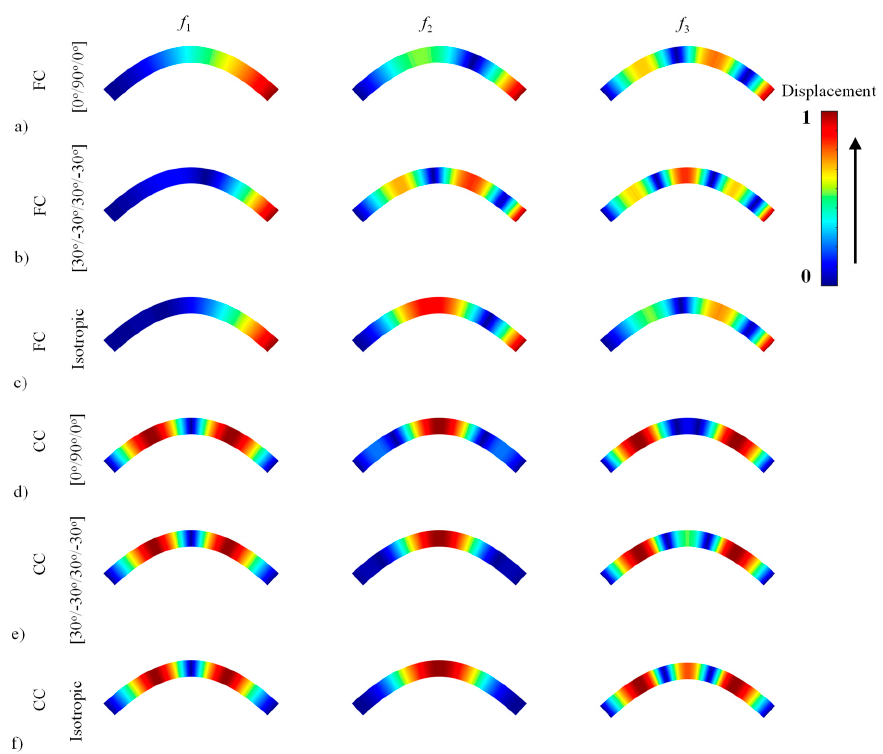
Figure A2. Several mode shapes for a paraboloidal composite laminated beam and a paraboloidal isotropic beam. Materials 2020 , 13 , x FOR PEER REVIEW